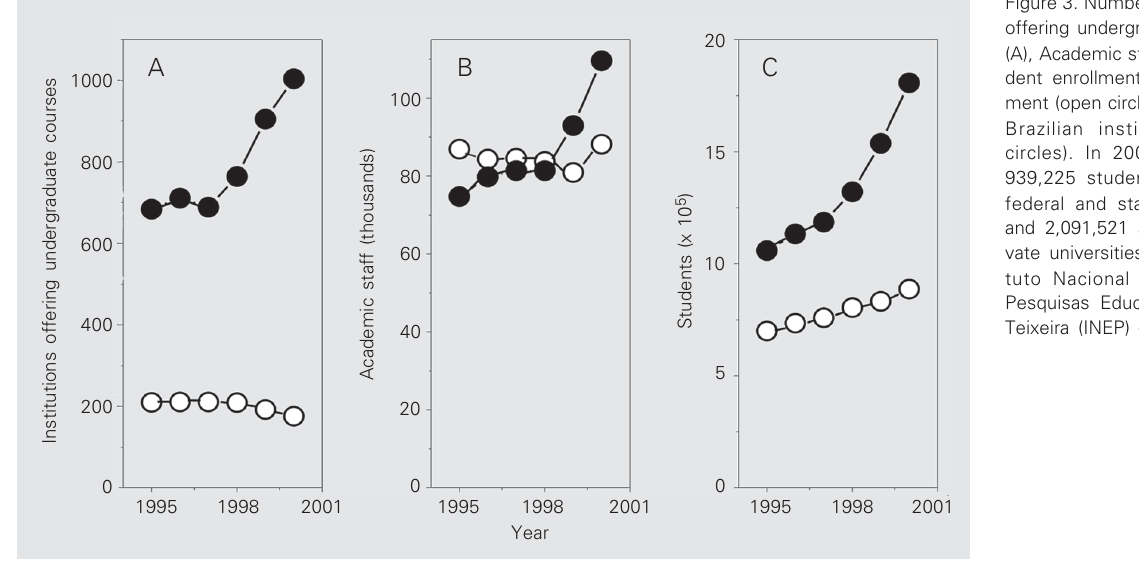
Figure 3. Number of institutions offering undergraduate courses (A), Academic staff (B) and Stu- dent enrollment (C) in govern- ment (open circles) and private Brazilian institutions (filled circles). In 2001 there were 939,225 students enrolled in federal and state universities and 2,091,521 students in pri- vate universities. Source: Insti- tuto Nacional de Estudos e Pesquisas Educacionais Anísio Teixeira (INEP) - 2001 Census.